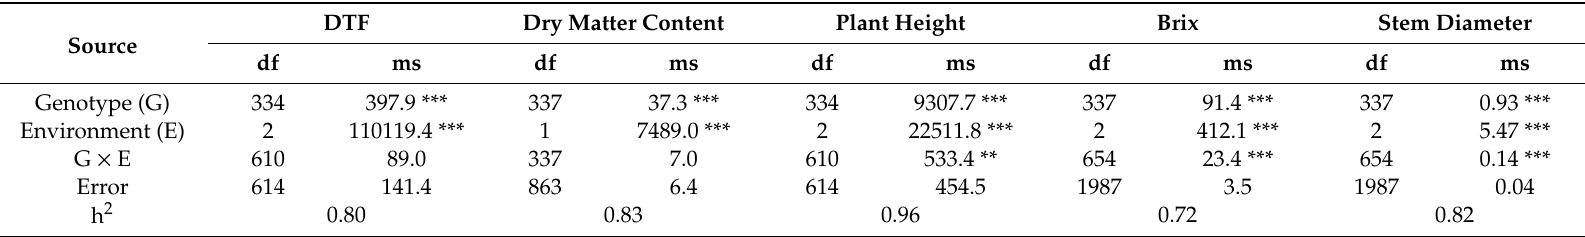
Table 9. Variances (mean squares, MS) and heritability for agronomical traits over all environments. G, E, G x E, and error-variance were computed using a general linear model in which genotypes and environments were considered as fixed and replicates as random e ff